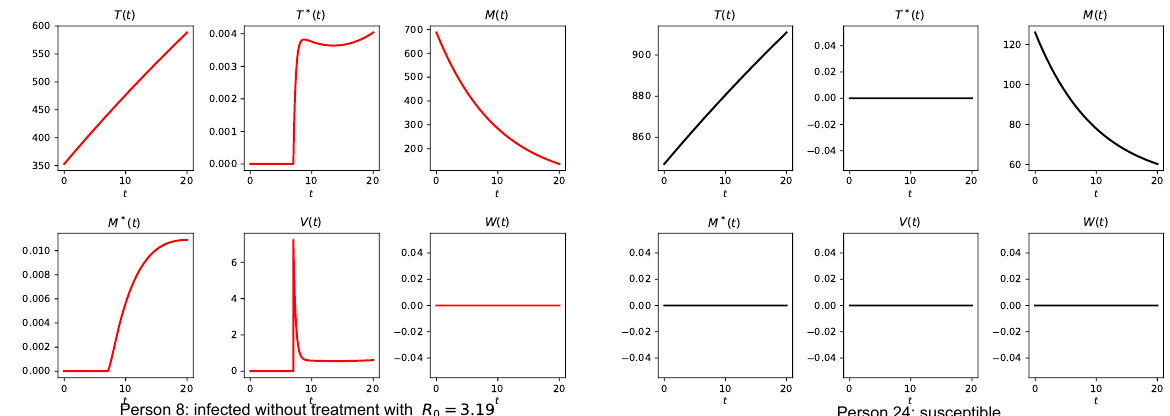
Figure 8. Immunological state of individuals 1, 8, 19, and 24 of the complex network simulated with N T = 25, τ = 20, γ = 3.4, and k = 2. (Black: person susceptible throughout the simulation time. Red: HIV carrier who in the final time did not take ART. Green: HIV carrier who in the final time takes